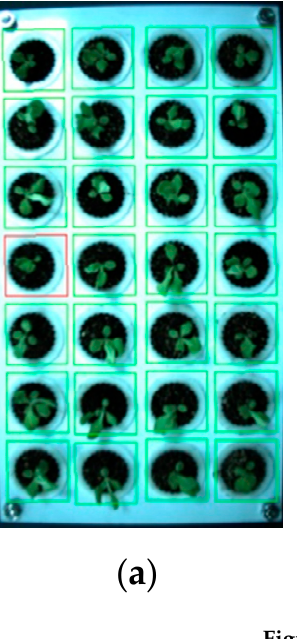
Figure 10. Detection results of lettuce seedling with different seedling age: ( a ) 17 d of seedling age; ( b ) 20 d of seedling age; ( c ) 22 d of seedling age. The changes in the number of pixels in the leaf area of lettuce seedlings from 17 d to 22 d of seedling age were counted, as shown in Figure 11. The black line is the